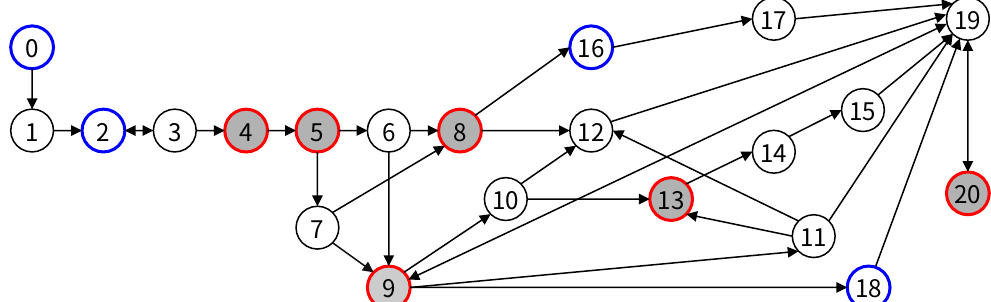
Figure 12. Graph for sinus surgical navigation system.